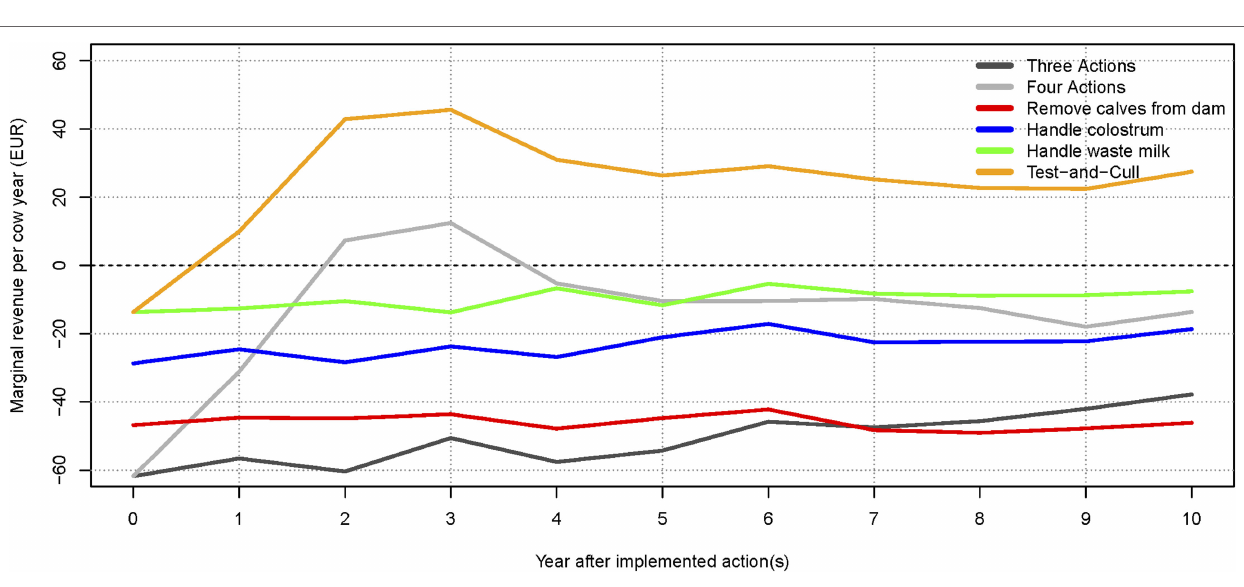
FIGURE 5 | Change in net revenue per cow year over time for the low-hygiene herd, relative to the baseline scenario . The marginal extra income for each action and combinations are shown. The net revenue of implementing the three most popular actions (handling colostrum and waste milk, and removing calves from the dam) increases after 6years but is still not profitable. The dotted line (at 0 A C) represents the baseline scenario (no